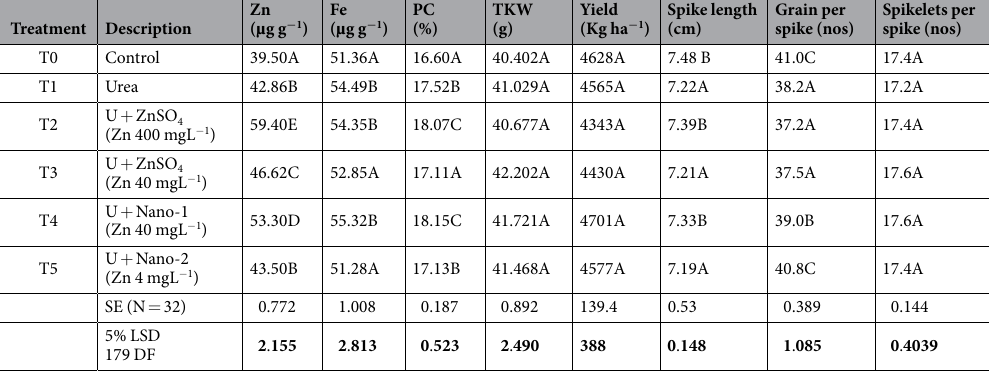
Table 2. Effect of different foliar treatments on the grain characteristics. Values indicate means of 2 genotypes × 4 replicates × 4 trials (years). Means with the same letter are similar at 5% significance level using Fischer’s LSD. LSD values are in bold font to differentiate from data values. PC denotes protein content; TKW denotes thousand kernel